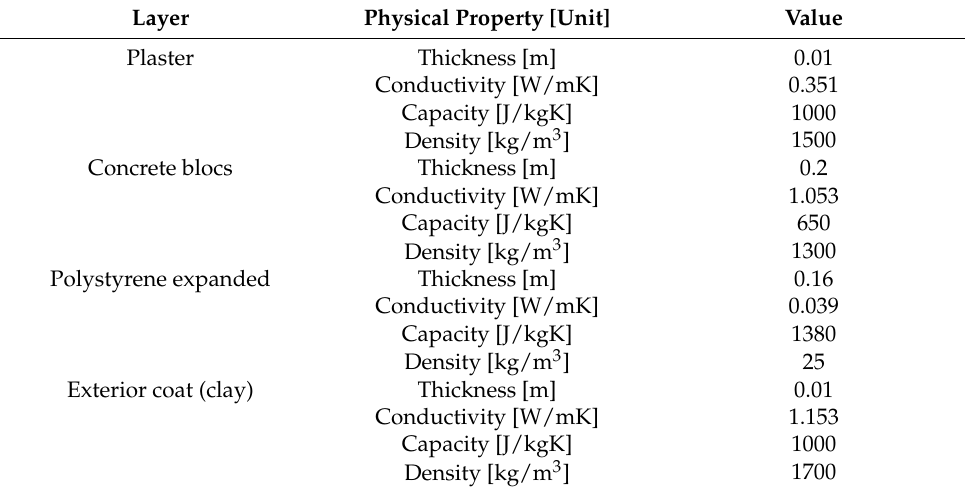
Table 3. Thermal properties of a heavy-structured wall.